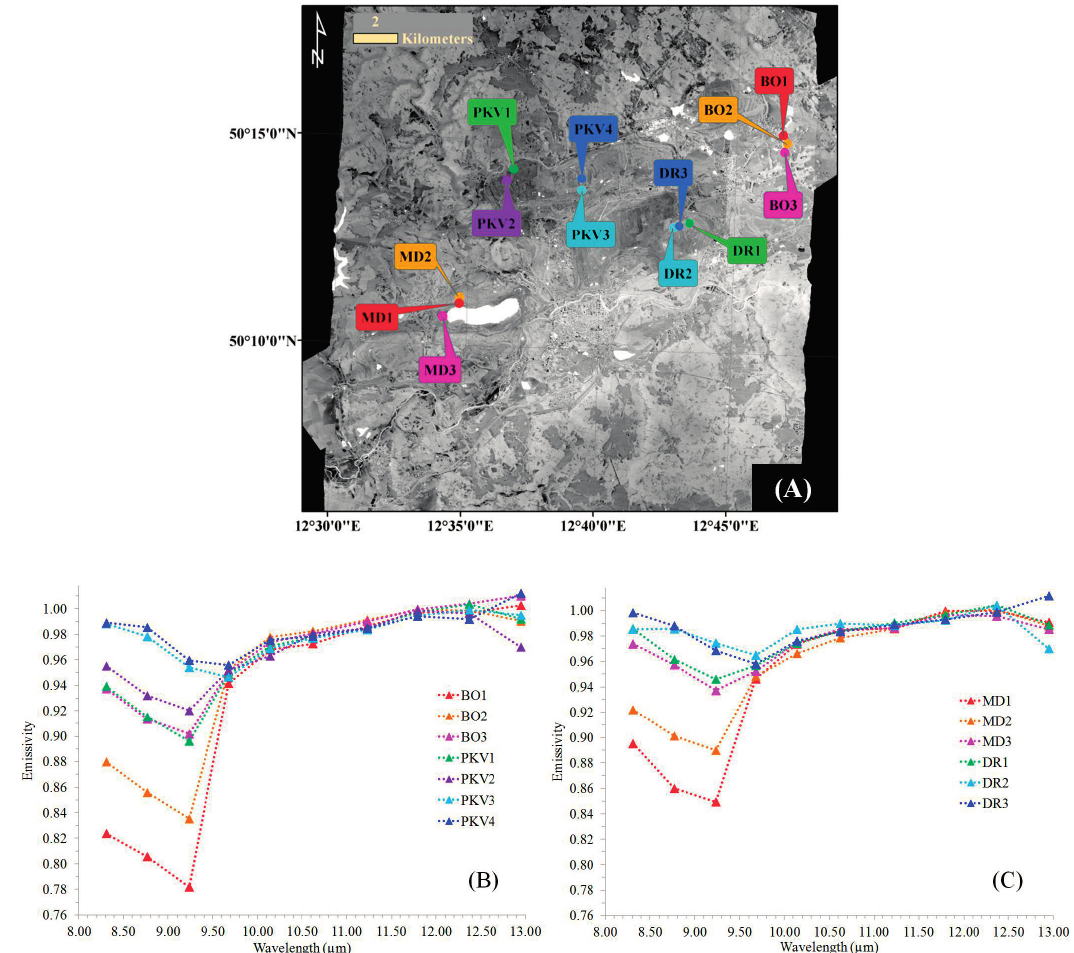
( B , C ) Airborne emissivity spectra of the land ROIs as calculated from the LWIR image PKV—Podkrusnohorska-vysypka, MD—Medard, and